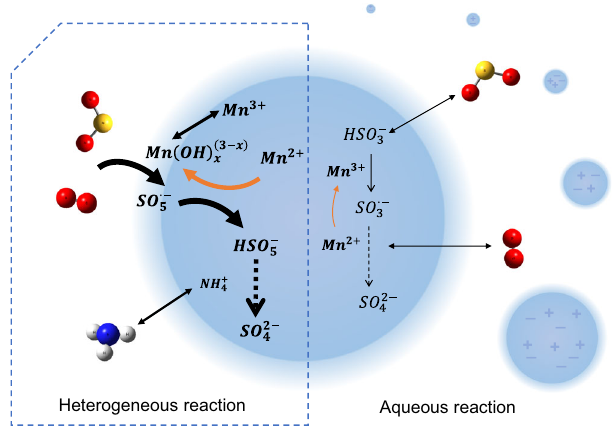
Fig. 4 Schematic of Mn-catalytic oxidation of SO 2 on the aerosol surface and in the aqueous phase. Red, blue, and white spheres represent oxygen, nitrogen, and hydrogen atoms, respectively.